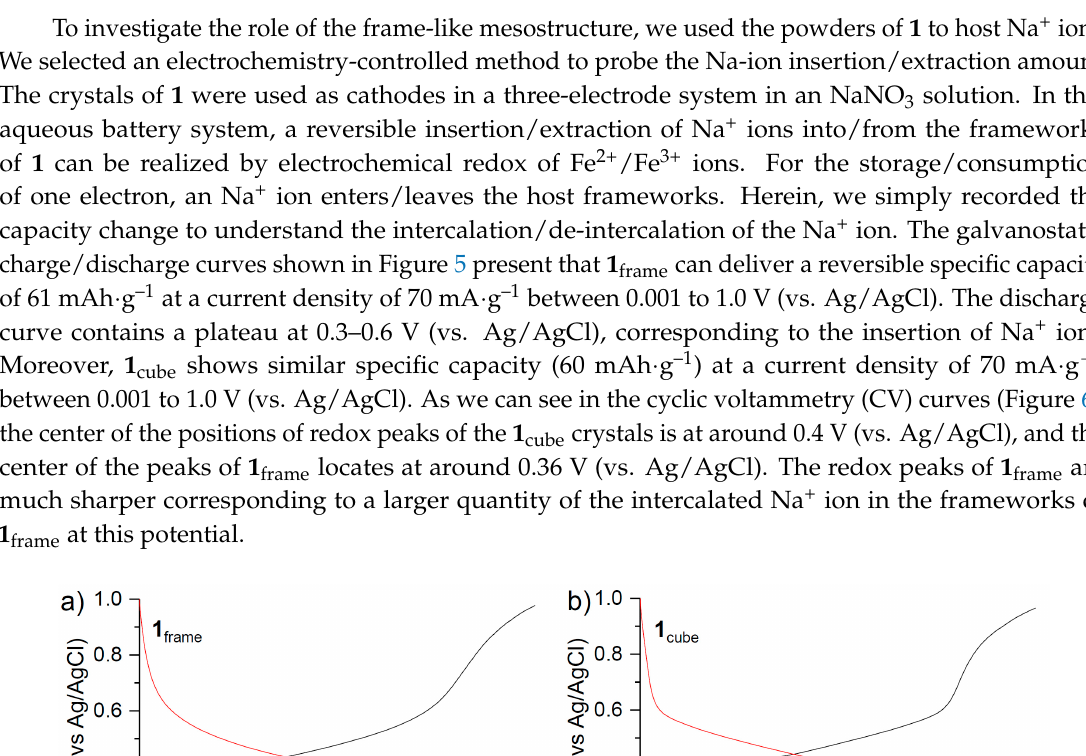
Figure 4. FT-IR spectra of 1 crystals.